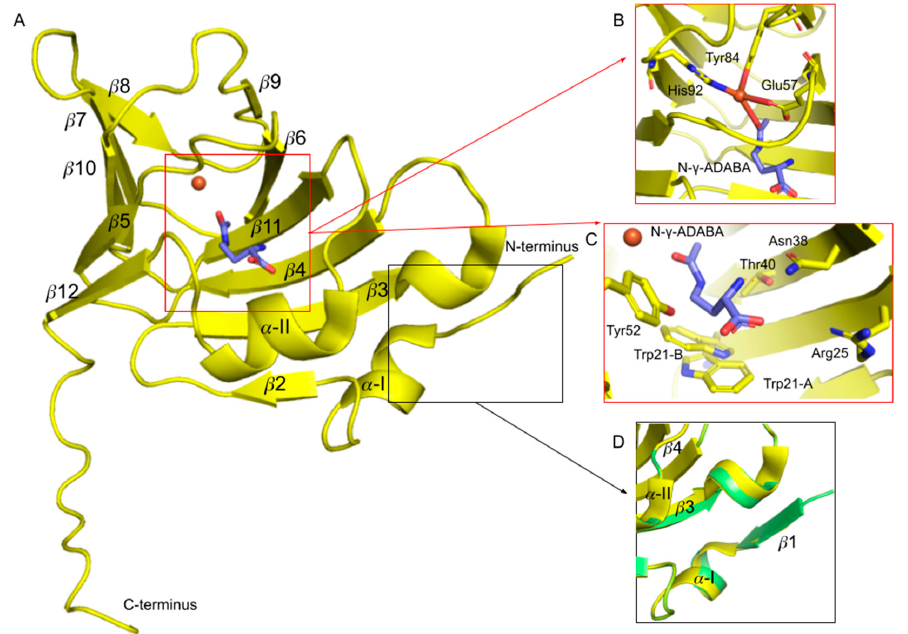
Figure 2. ( A ) EctC monomer from P. lautus with labelled secondary structure elements; iron ion in orange and N- γ -ADABA substrate molecule in purple. ( B ) Zoom into the iron binding site with Glu57, Tyr84, His92 and N- γ -ADABA (shown as sticks) coordinating the iron ion. Note that the bond lengths between the metal and its ligands are too long for effective coordination. ( C ) Zoom into the active site of EctC with Trp21 (two possible orientations, Trp-A/Trp-B), Arg25, Asn38, Thr40 and Tyr52 interacting with the ligand (purple). Orange dots mark hydrogen bonds between the substrate molecule and neighbouring amino acid residues in the crystal structure [1] (PDB code: 5ONN). ( D ) Zoom into the structure of the N-terminus, which changes from unordered in the monomer to a β structure upon dimerization (yellow—5ONN crystal structure—monomeric form; green—fragment of the dimeric